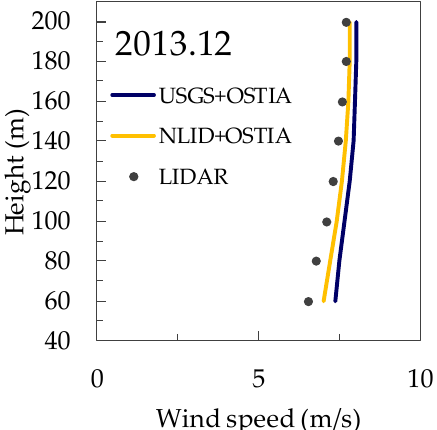
Figure 9. Effect of land-use data on the monthly average wind speed at the Choshi site in December 2013.